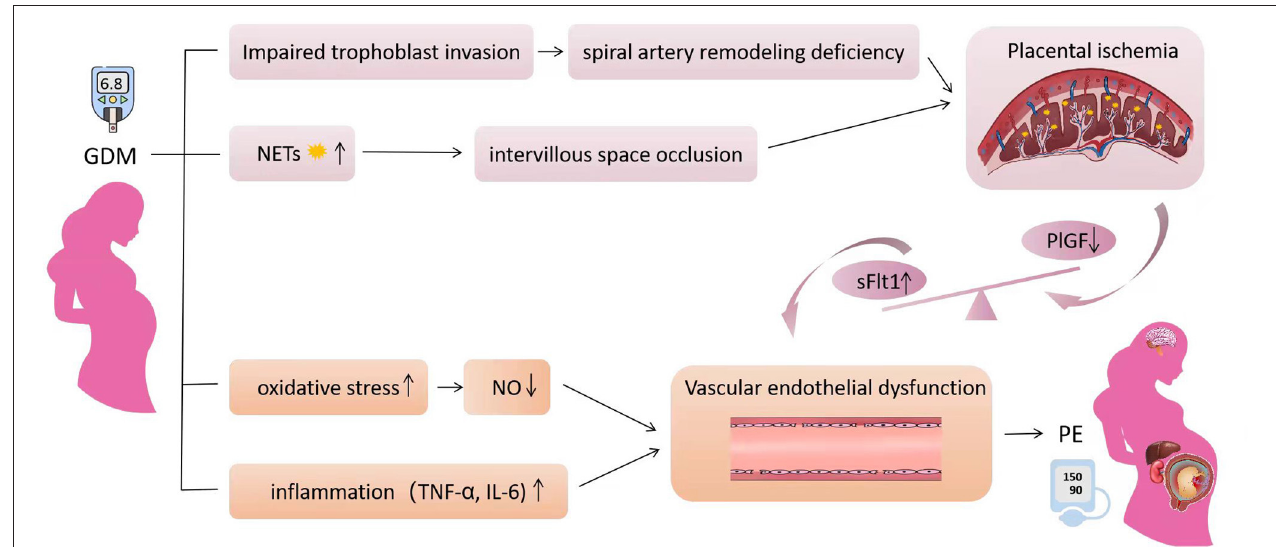
FIGURE 1 | The mechanism of gestational diabetes mellitus affecting the occurrence of preeclampsia. Hyperglycemia inhibits trophoblast migration and invasion by inducing trophoblast inflammation and autophagy, which can lead to uterine spiral artery remodeling deficiency. Neutrophils in GDM are over-activated and release excessive neutrophil extracellular traps resulting intervillous space occlusion. The two factors cause placental ischemia and hypoxia, resulting in the imbalance of anti-angiogenic factors, which can lead to vascular endothelial injury. In addition, increased oxidative stress in GDM leads to decreased nitric oxide synthesis and activity, resulting in vasodilation dysfunction. The increased inflammatory factors further aggravate the vascular endothelial injury. The clinical symptoms of preeclampsia eventually appeared, including hypertension and multiple organ injury. Obesity exaggerates all pathways affecting